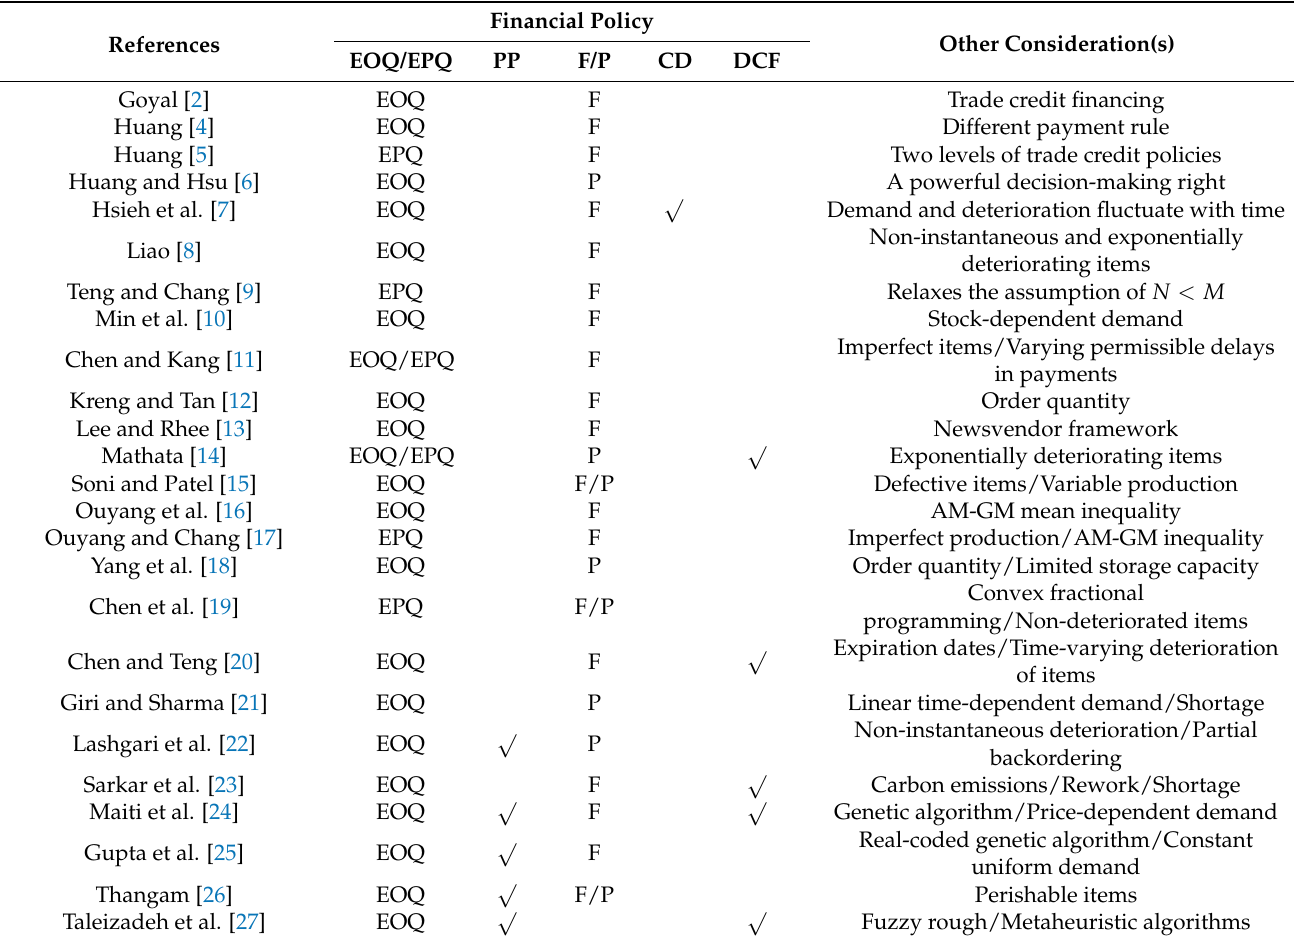
Table 1. Comparison of the financial policies in existing models with those in the proposed